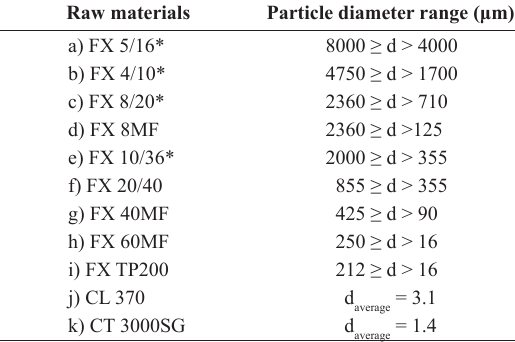
Table 2. Raw materials used in the formulation of the castables (“FX”-type materials were a courtesy of ELFUSA. CL370 and CT3000SG were a courtesy of